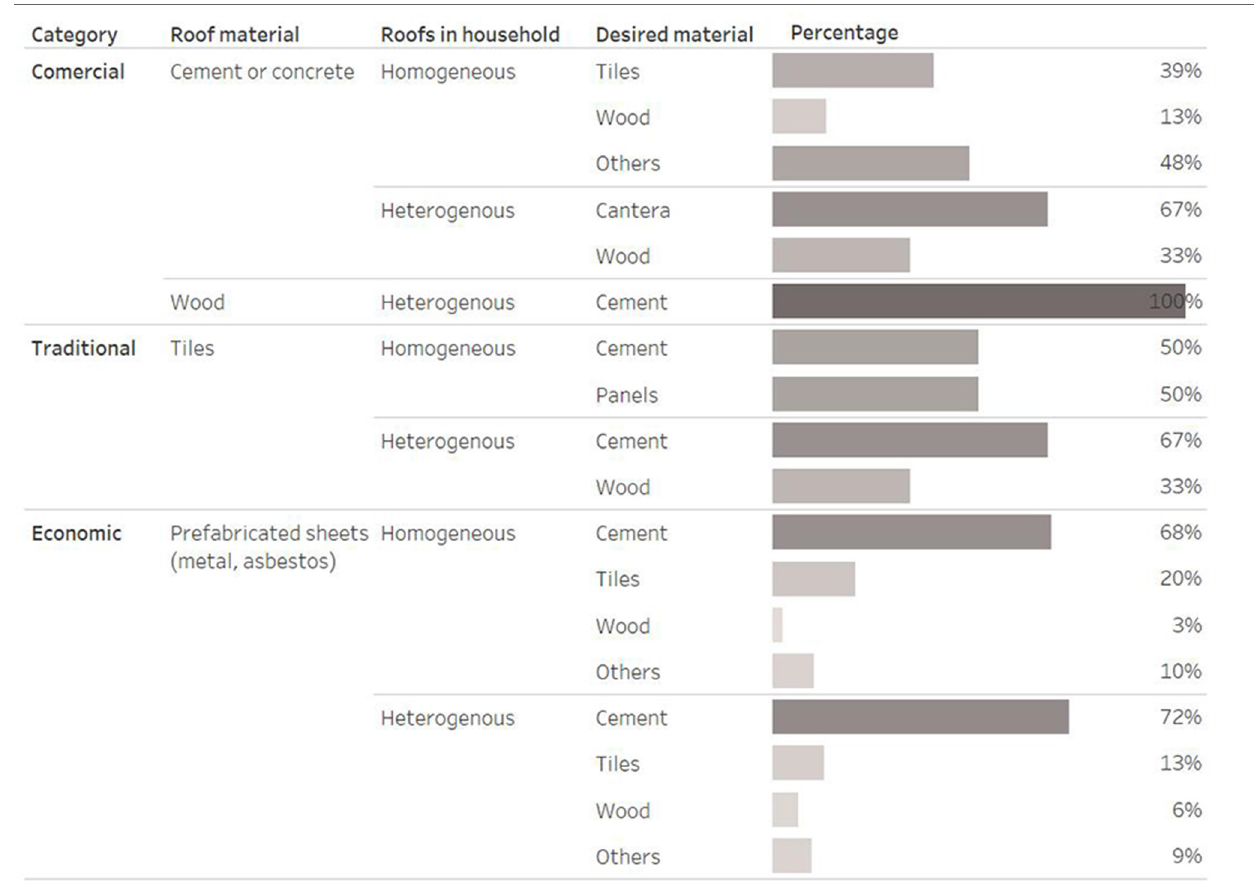
TABLE 8 | Roof materials and ideal types in ZMVO